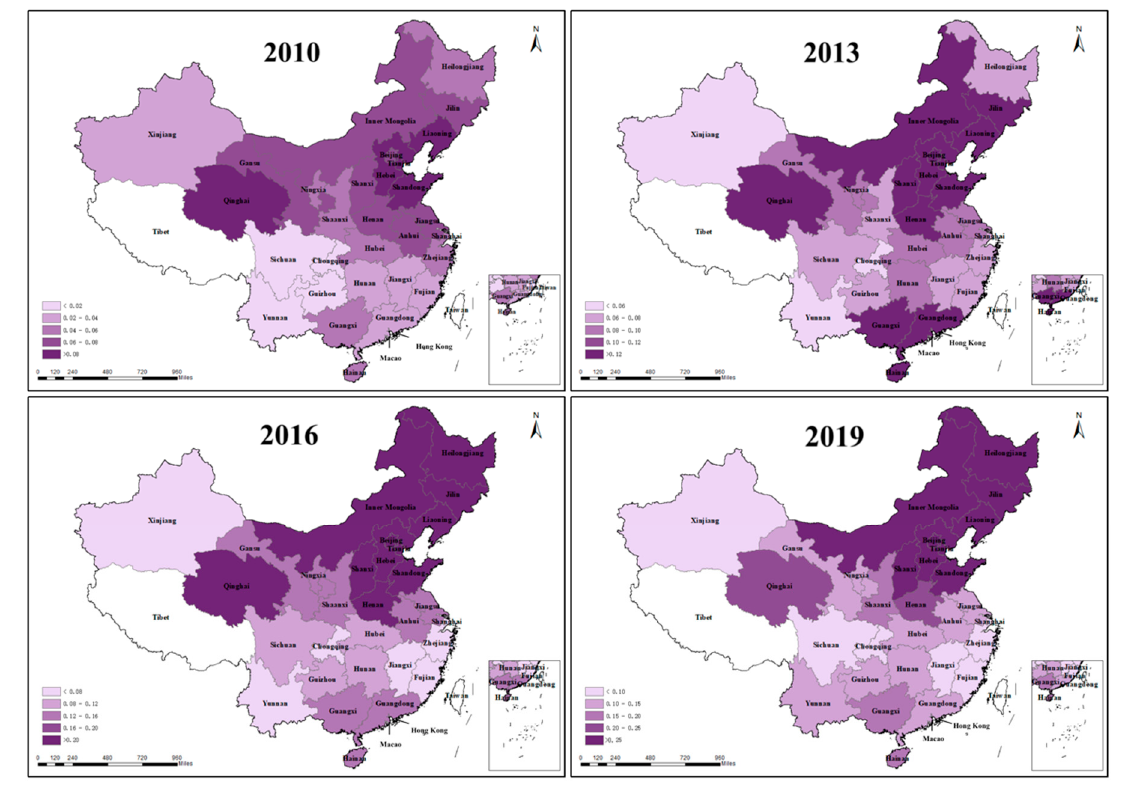
Figure 4. Spatial and temporal variation in regression coefficients of ICT industrial co-agglomeration (2010, 2013, 2016 and 2019).